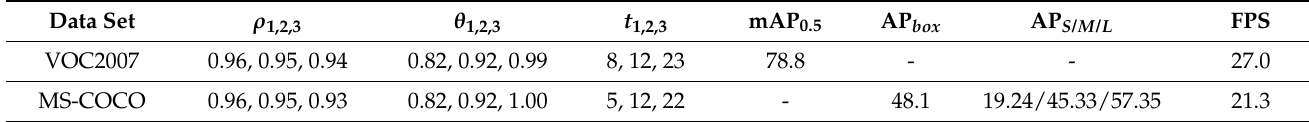
Table 3. The best PPHT parameters obtained during tuning for each dataset, mAP 0.5 , and FPS for the proposed model tested on the VOC2007 test set in addition to AP box , AP 0.5,0.75,0.95 , on MS-COCO minival using the same